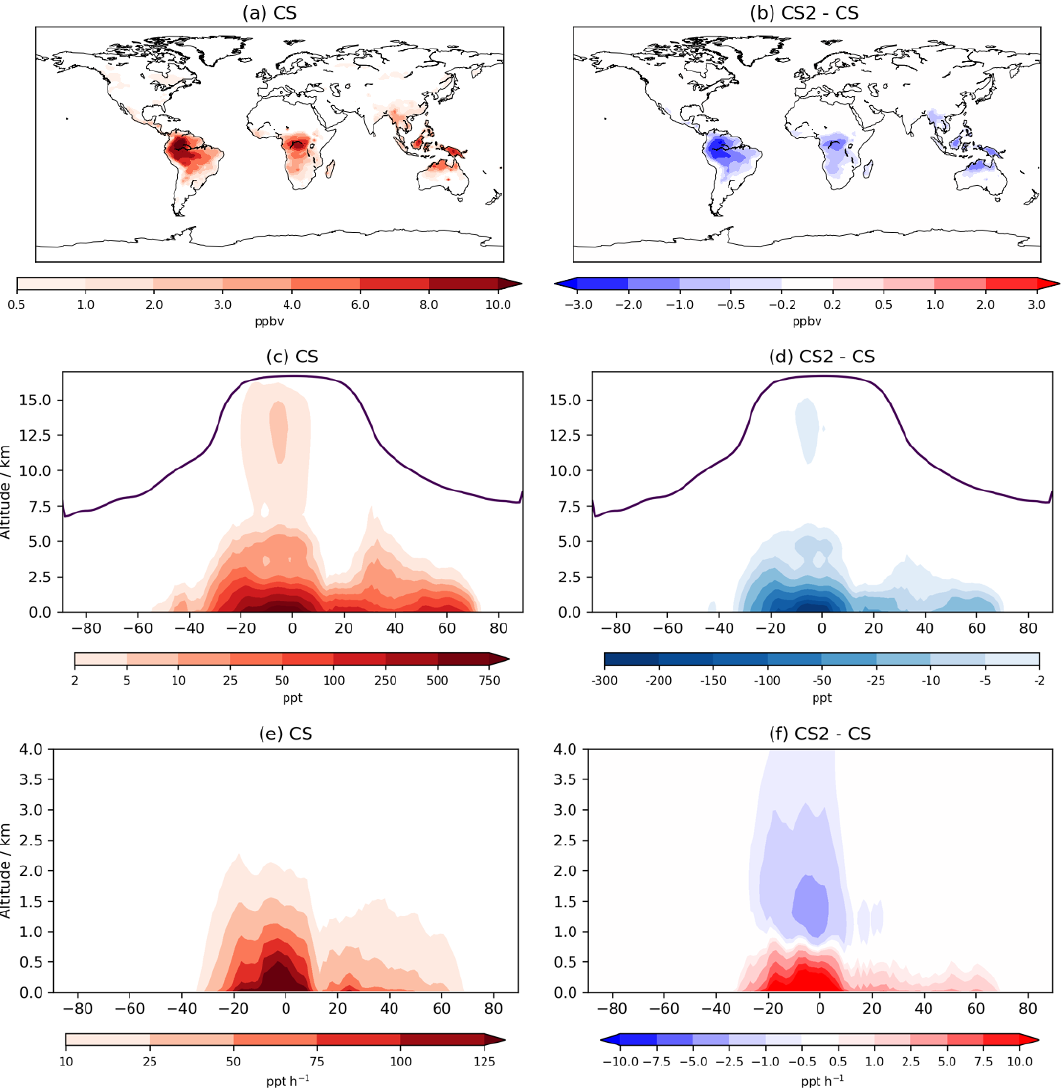
Figure 7. Annual mixing ratio of isoprene averaged over the lowest ∼ 100m (a) in CS and (b) the difference between CS2 and CS. Annual zonal mean mixing ratios in (c) CS and (d) the difference between CS2 and CS (note the log scales used for colour maps). Annual average total oxidation flux of isoprene (e) in CS and (f) the difference between CS2 and